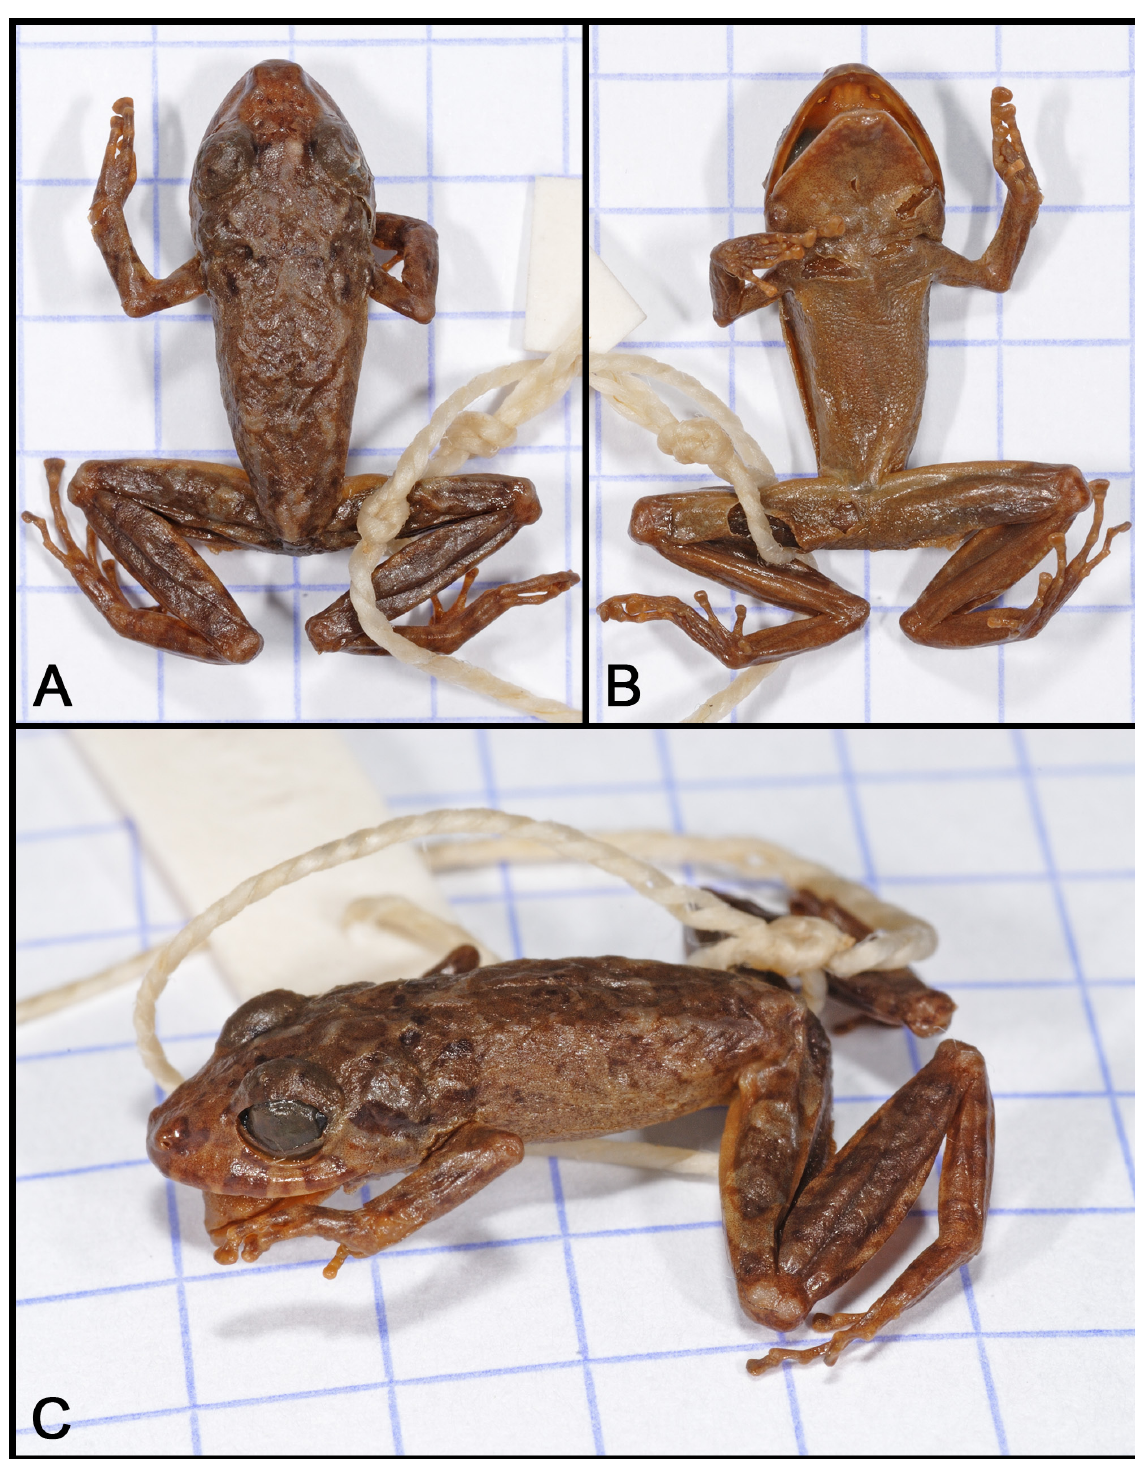
Fig. 2. Pristimantis marmoratus (Boulenger, 1900). Preserved adult ♂, holotype (BMNH 1947.2.16.92). A . Dorsal view. B . Ventral view. C . Dorsolateral view. Grid squares = 5 mm. Photographs by